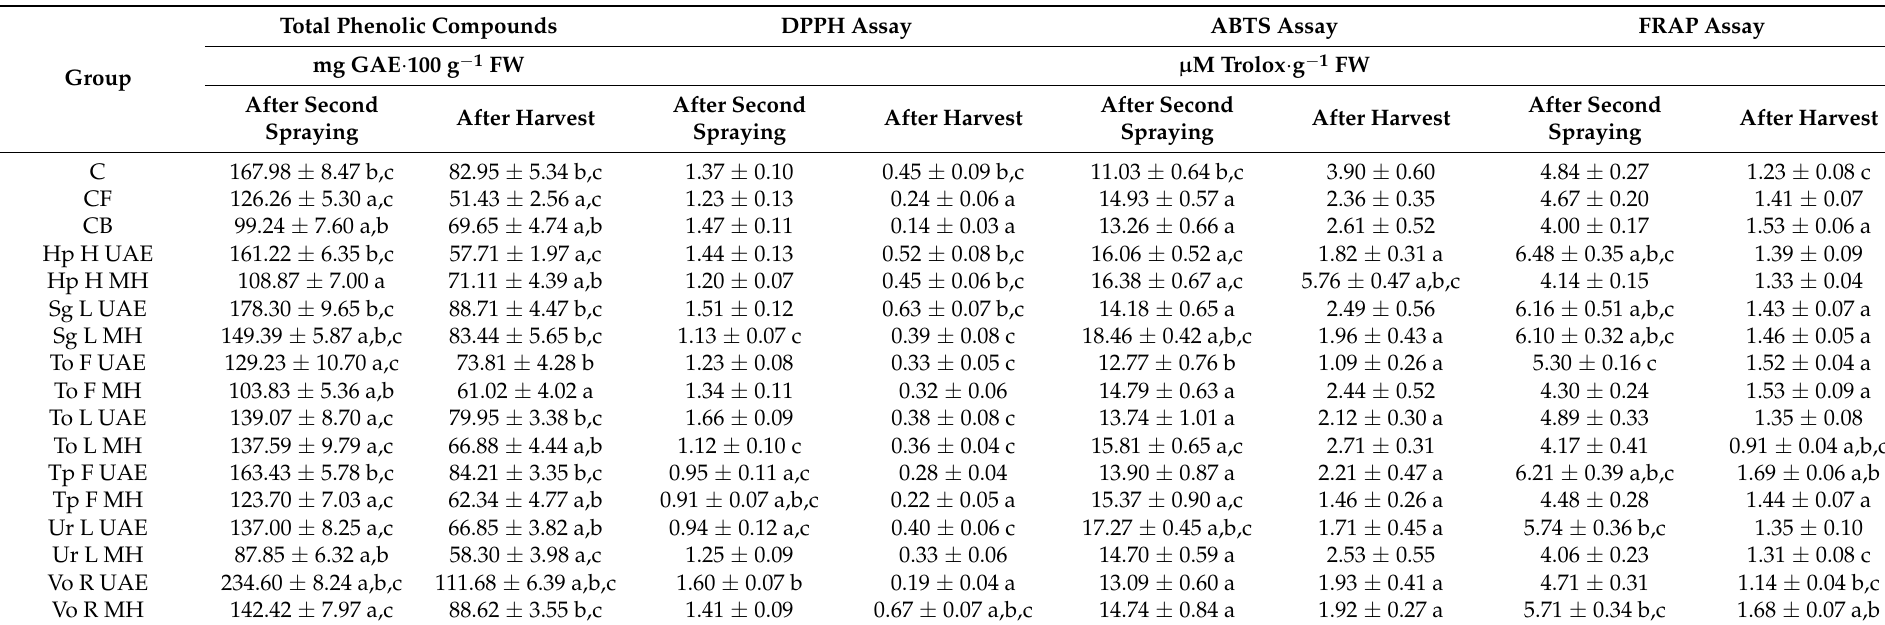
Table 3. Effect of the foliar application of the botanical extracts on the total phenolic compounds content and the antioxidant activity (DPPH assay, ABTS assay, and FRAP assay) of leaves after second spraying and cabbage head after harvest ( n = 4, mean ±